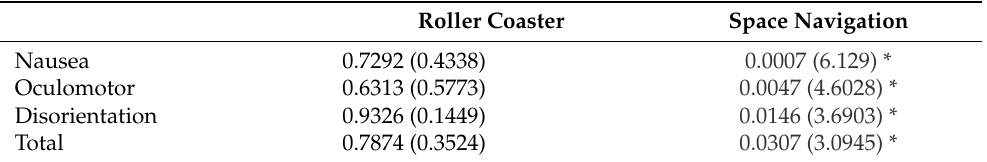
Figure 5. After sickness level as categorically assessed by the SSQ for two test contents—a roller coaster ride (left) and space navigation (right). A general trend of sickness reduction was found with the three conditions against the baseline (F-FoV), in particular in the space navigation case (statistically significant difference between F-FoV and F-FoV+P-ROF). However, there was no clear winner among the three. */** indicate statistically significant differences. Table 1. ANOVA results with regard to effects on sickness reduction for the two test contents: p -value (f-value); * indicates statistically significant differences.